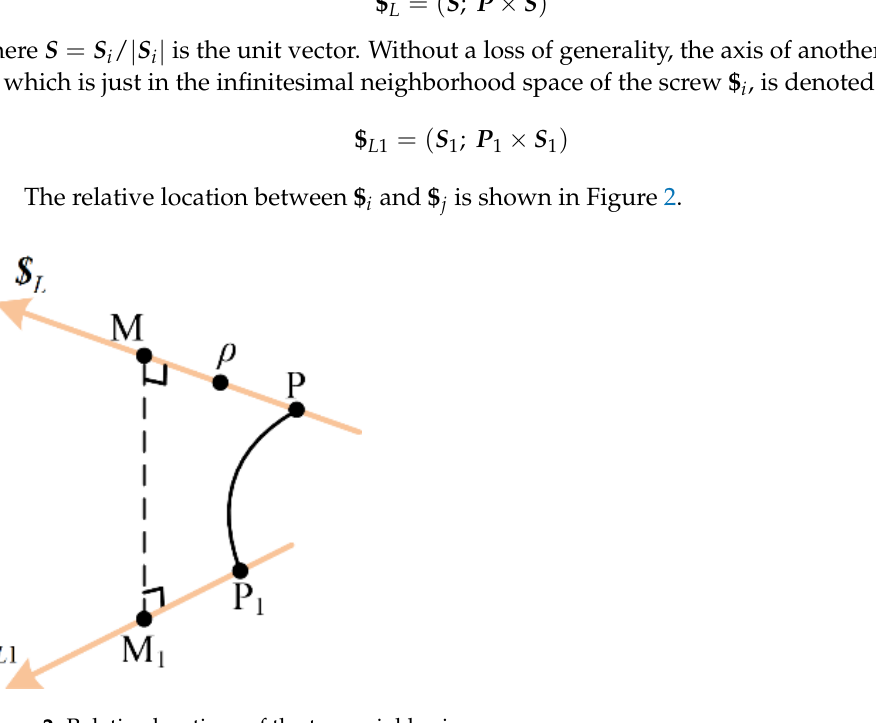
Figure 2. Relative locations of the two neighboring screw axes.